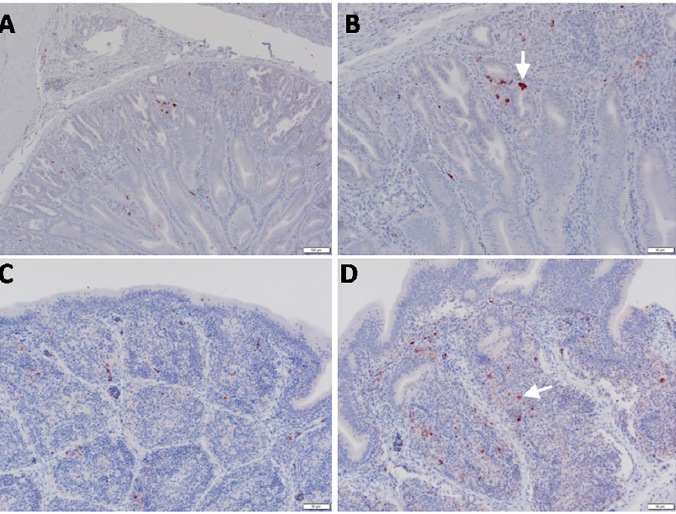
Fig 6. Detection of viral NP antigen in proventriculus and bursa of Fabricius by IHC. ( A ) Proventriculus of infected birds (X = 50 μ m). ( B ) Glandular epithelium of proventriculus (arrow) (X = 20 μ m). ( C and D ) Lymphocytes in follicular layer of bursa of Fabricius of infected birds (arrow) (X = 50 and 20 μ m, respectively).